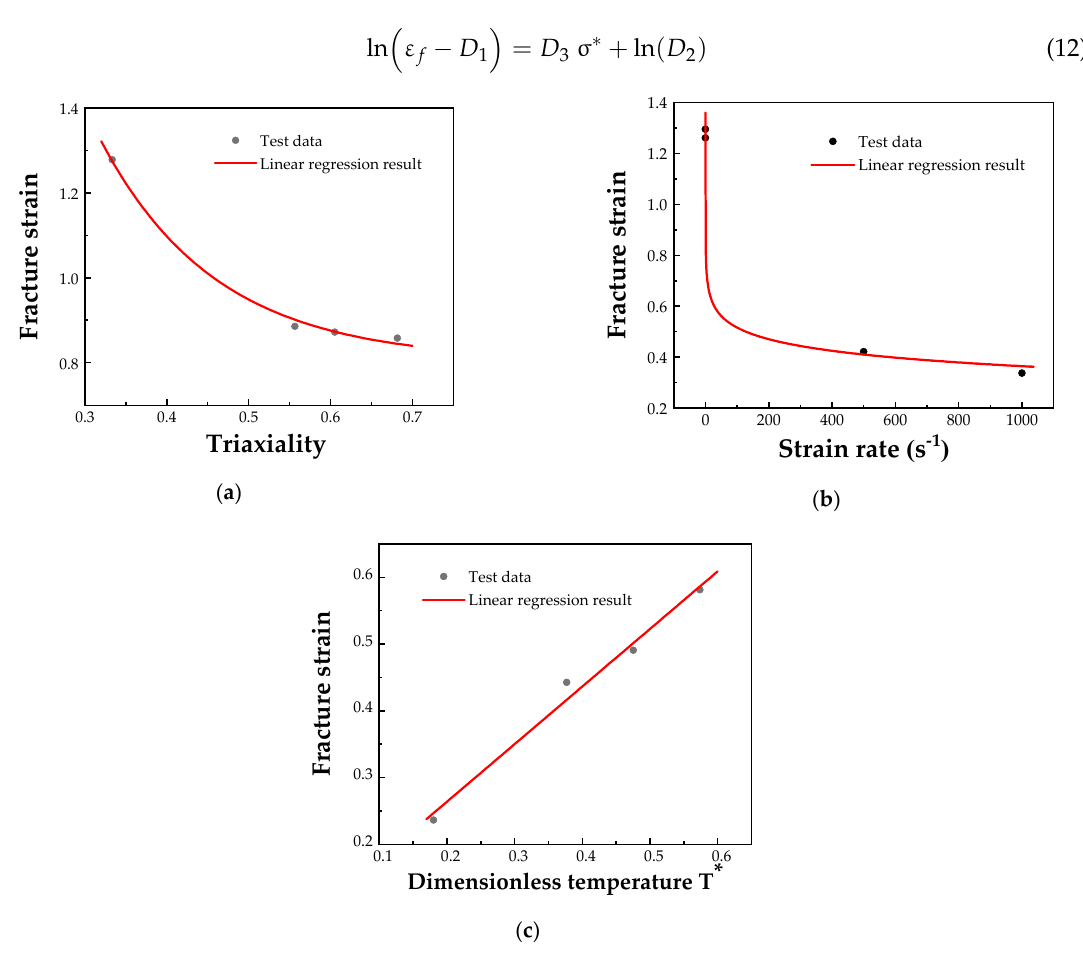
Figure 8. J-C damage model constants fitting results ( a ) triaxiality related constants D 1 , D 2 , D 3 ; ( b ) strain rate related constants D 4 ; ( c ) temperature related constants D 5 .